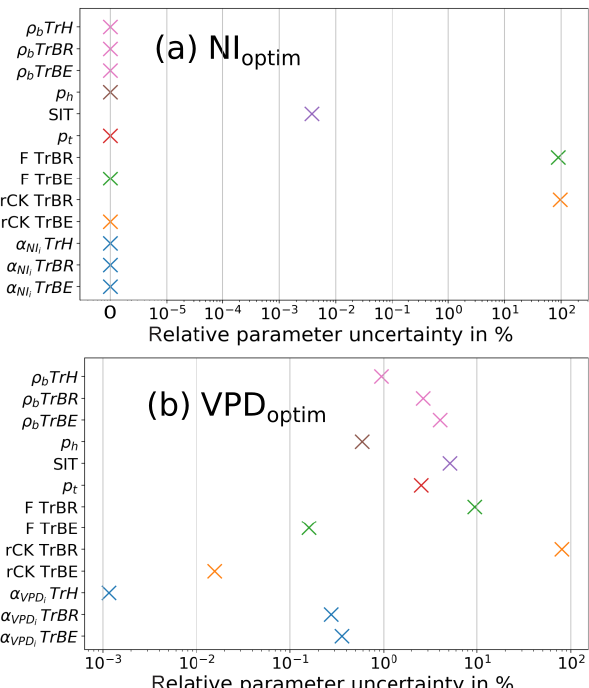
Figure 6. Relative uncertainty in model parameters after optimiza- tion for (a) NI optim and (b) VPD optim . The relative uncertainty is the ratio of the uncertainty after the optimization (range of all pa- rameter sets with low cost, below the 0.05 quantile) divided by the uncertainty before the optimization (range of the parameters for the optimization). Low and high values of relative uncertainty indicate strongly and weakly constrained parameters, respectively. SIT de- notes the surface intensity threshold. PFT-dependent parameters are grouped with the same